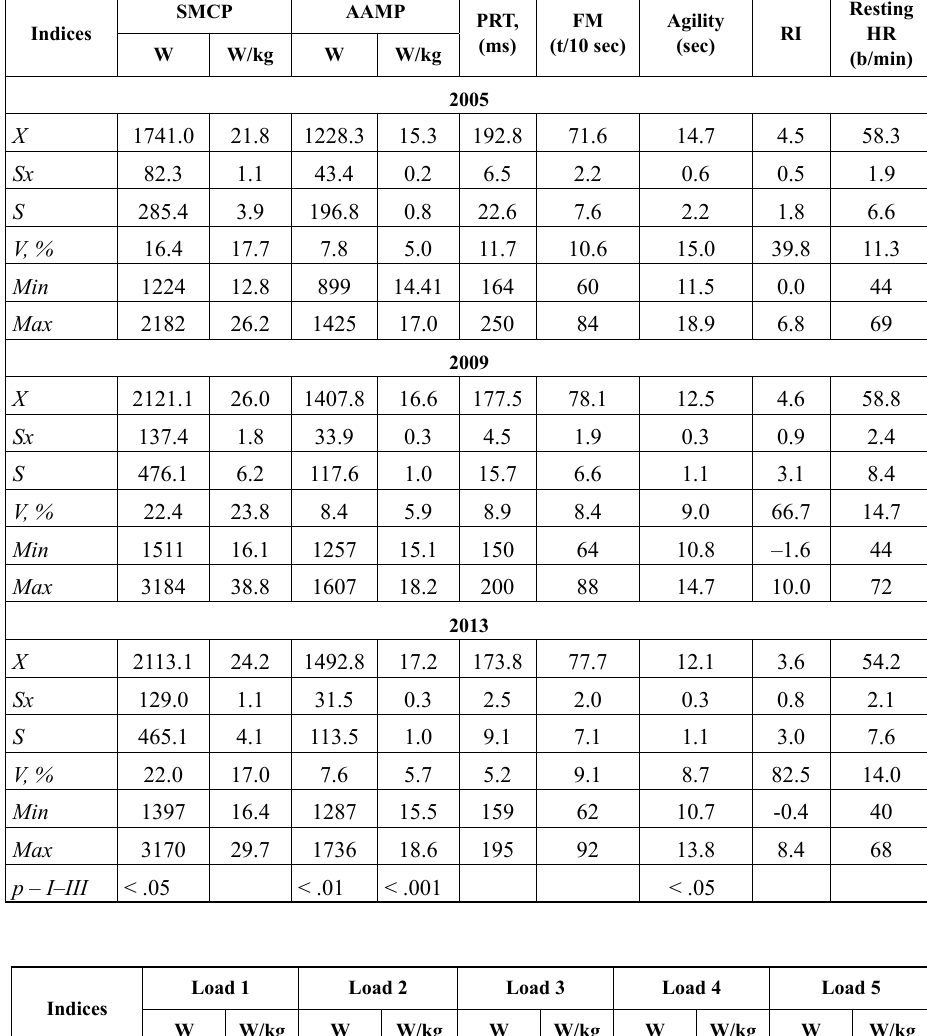
Table 2. Comparative characteristics of Lit- huanian deaf basketball national team members’ muscle capacity, psycho - motor functions, agility and blood circulatory system’s functional ca - pacity results in 2005, 2009 and 2013